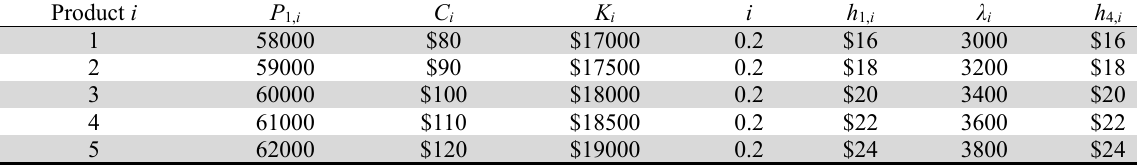
Assumption of variables’ values of a single-stage scheme of the same problem (1/2) Product i